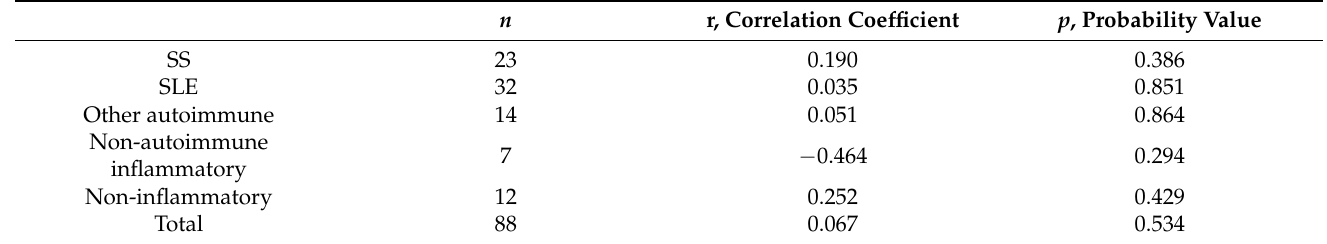
Table 4. Correlation by Spearman-Rho of circulating NfL level and anti-NR2 antibody titer in the different groups of patients with rheumatic diseases. n r, Correlation Coefficient p , Probability Value